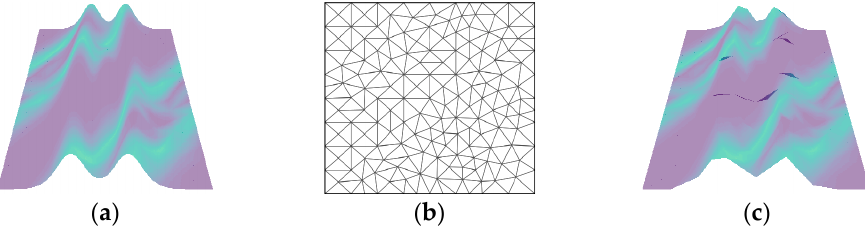
Figure 2. Approximation of the real random field using the finite element method: ( a ) Real random field; ( b ) Triangular grid; ( c ) Approximated random field. Figure 2a: A continuously indexed spatial random field; (b): Division of the research area into non-overlapping adjacent triangles; (c): Approximate spatial random field repre- sented by the finite element on the spatial random field of Figure 2a based on the piecewise the approximate spatial random field to the real spatial random